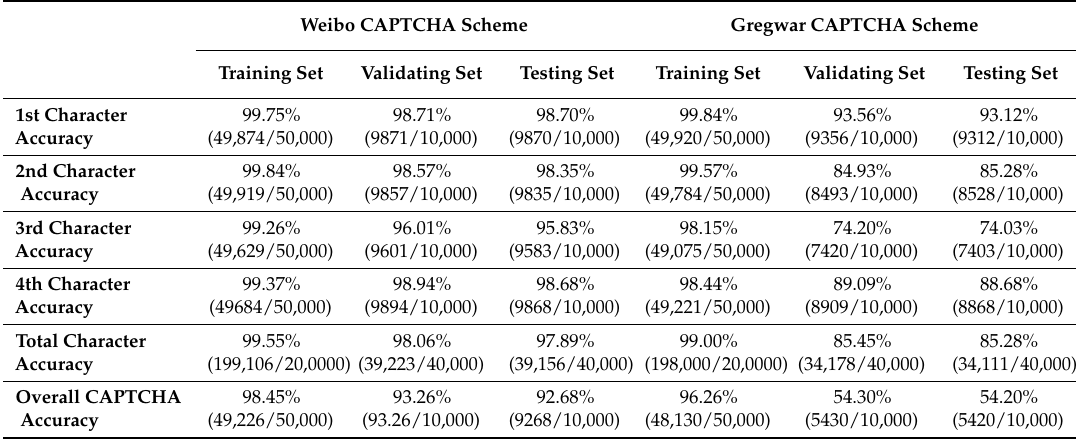
Table 2. Accuracies of individual characters and overall CAPTCHAs in